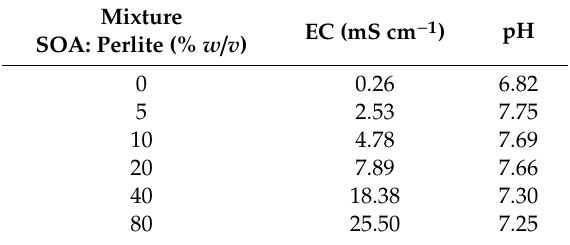
Table 2. Electrical conductivity and acidity in six mixtures of SOA: perlite